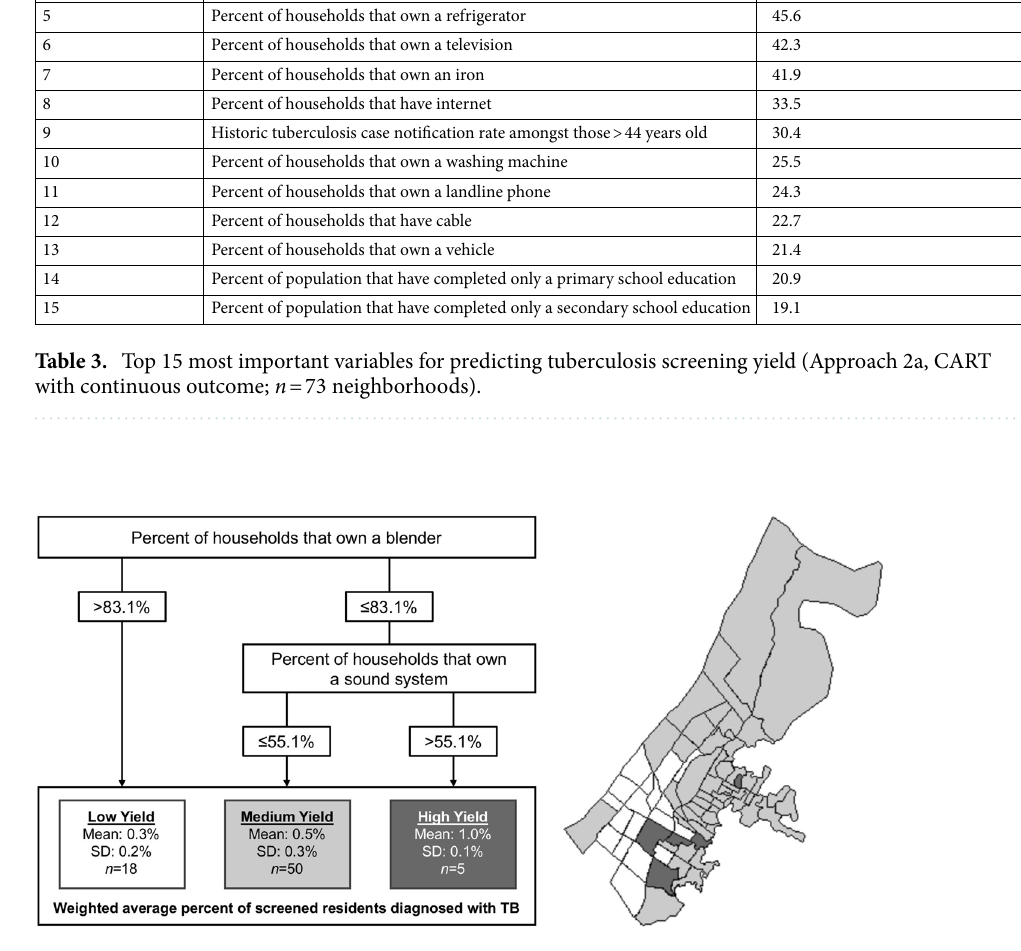
Figure 2. Distribution of tuberculosis screening yield according to neighborhood risk category (Approach 2a, n = 73 neighborhoods). Map was created by MBB using ArcMap Desktop version 10.8 (Environmental Systems Research Institute, Redlands, California, USA; https:// www. esri. com/ en- us/ arcgis/ produ cts/ arcgis- deskt